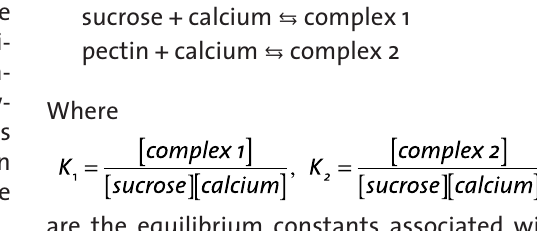
Table 5 (left): Influence of polysaccharides on the kinetic and rheologi- cal parameters. Table 6 (right): Influence of ethanol on the different kinetic and rheo- logical parameters. Figure 14 (bottom): a.) “egg box” model for the jonctions zones due to inter- actions between galactur- onic acid residus and calci- um